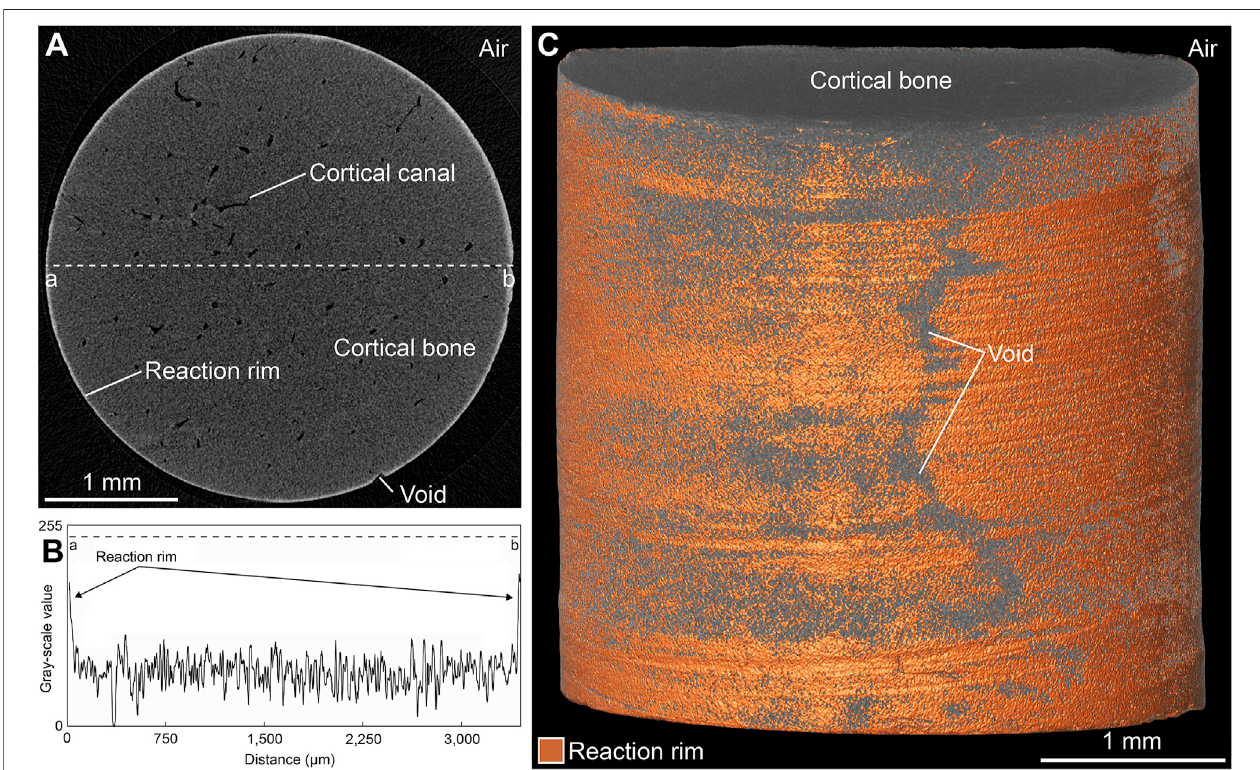
FIGURE8| Visualization ofthe reaction rim foundin FWand FWS samples following theexperiments. (A) Virtual section ofarepresentative sample. (B) Grey value distribution of a line from point a to b as indicated in (A) . (C) Combined volume and surface rendering of the sample virtually sectioned in (A) illustrates an unevenly distributed reaction rim. Note the presence of areas not possessing a reaction rim ( “ void ”